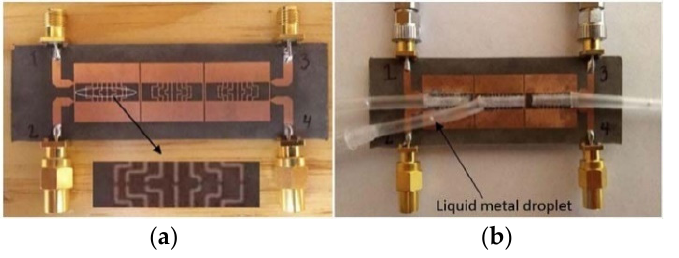
Figure 11. ( a ) Fabricated design of the microstrip filter; ( b ) mircrofluiding channel implementation [35].